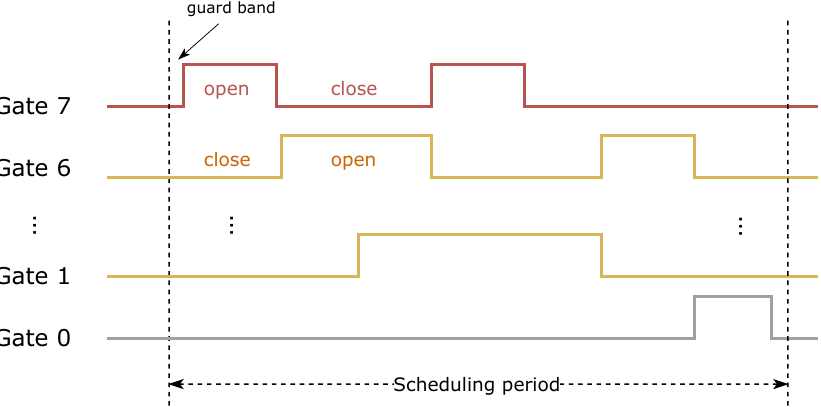
Figure 7. An example of TAS scheduling timing in a TSN (corresponds to Figure 8).